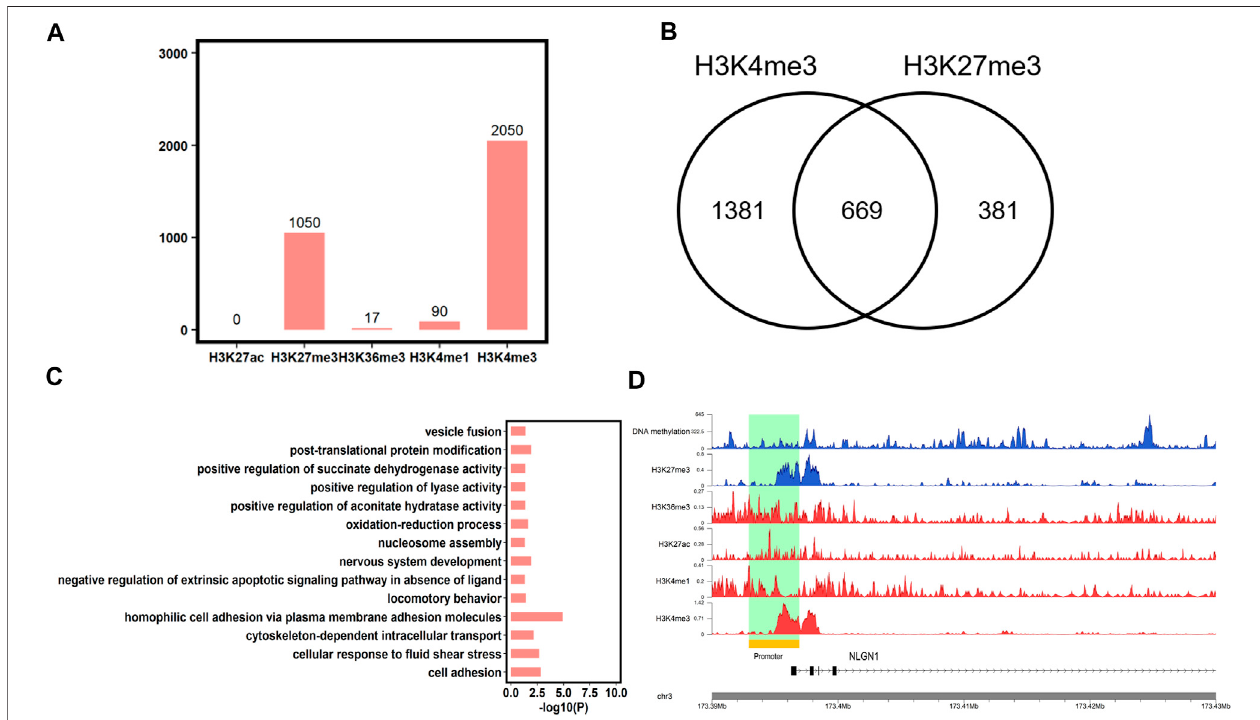
FIGURE 6 | Epigenetic marks at conserved HMRs between human and pig. (A) The number of conserved HMRs between human and pig showed overlap with H3K4me1, H3K4me3, H3K36me3, H3K27ac, and H3K27me3. (B) The number of conserved HMRs simultaneously marked by H3K4me3 and H3K27me3. (C) Gene Ontology analysis of genes associated with conserved HMRs and bivalent domains at the promoters ( p < 0.05). (D) Gene tracks showing DNA methylation, H3K4me1, H3K4me3, H3K36me3, H3K27ac, and H3K27me3 signal in human sperm at one representative poised gene, NLGN1